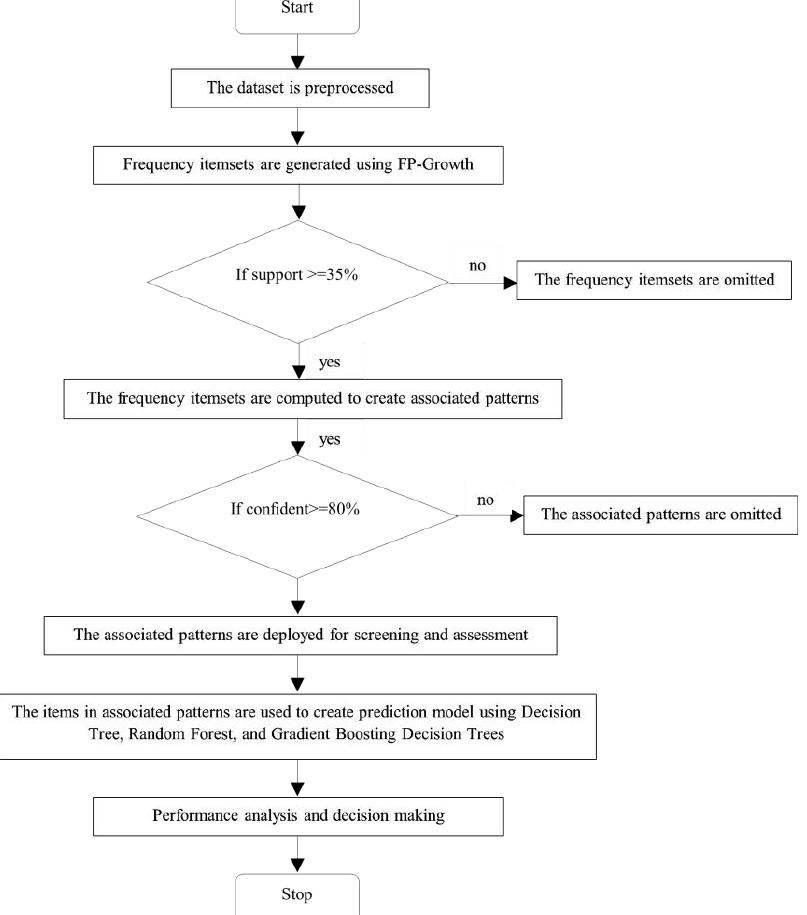
Figure 1. Flowchart of the research